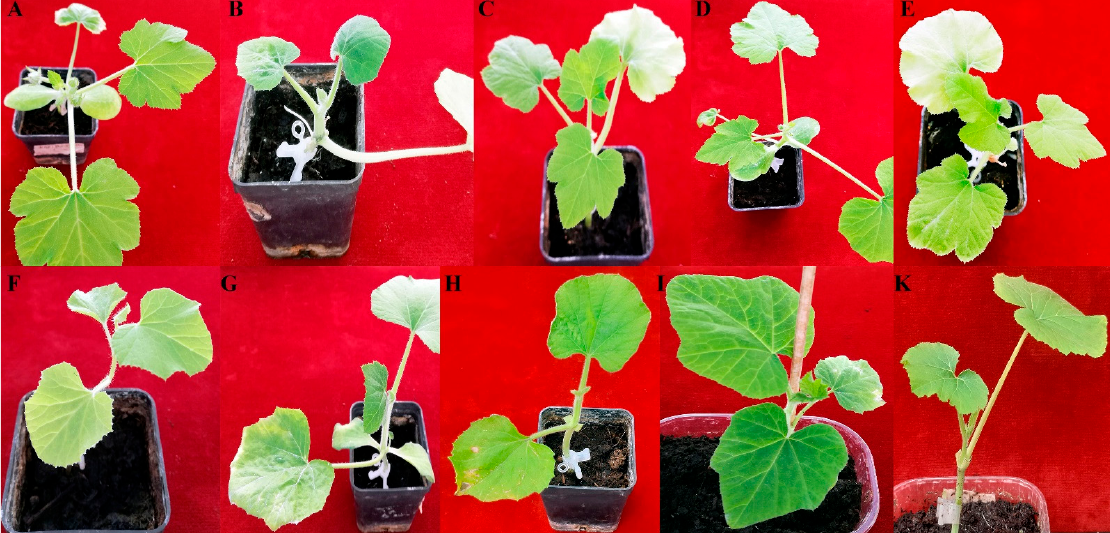
Figure 4. Disease phenotype induced by ToLCNDV-Le on the different graft combinations with susceptible and moderately susceptible cucurbit genotypes grafted on the tolerant local ecotype C. melo var. Barattiere used as common rootstock. Pictures taken at 14 dpi with ToLCNDV-Le: C. pepo cv . President ( A ); C. moschata cv. Moscata di Provenza ( B ); C. pepo cv. Howden ( C ); C. pepo cv. Scuro di Milano ( D ); C. pepo cv. Corritore ( E ); C. melo ecotype Retato (Cantalupo) ( F ); C. moschata cv. Cucuzza Genovese ( G ); L. siceraria spp. ( H ); C. melo cv. Retato standard (F1 hybrid) ( I ); C. pepo ac- cession 6 ( K